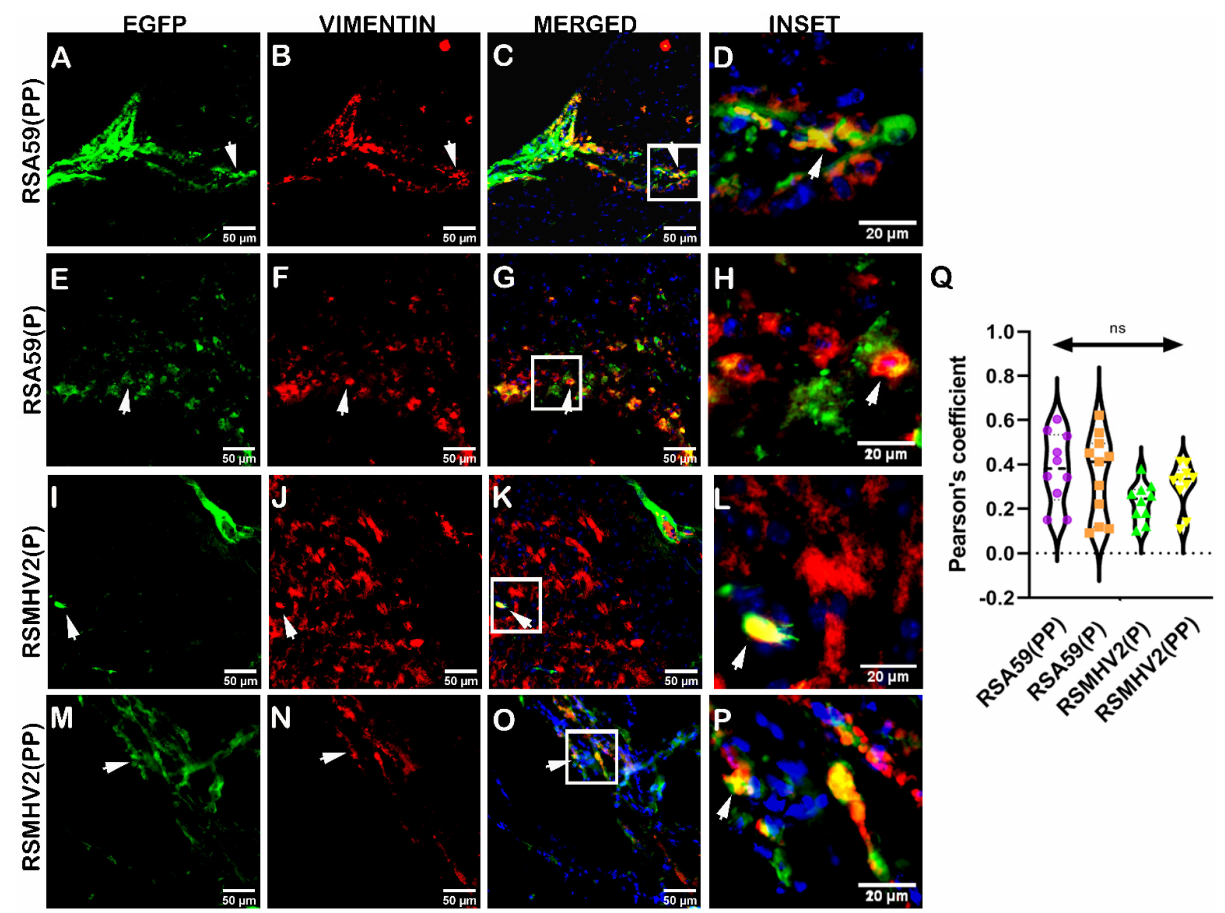
Figure 11. Colocalization of two proline containing strains RSA59(PP), RSMHV2(PP) and single proline containing strains RSMHV2(P) and RSA59(P) infection with choroid plexus fibroblasts in the brain of mice at day 5 p.i. Cryosections of infected mouse brains were immunofluorescently labeled with vimentin ( B , F , J , N ). EGFP images denote infected cells in the tissue ( A , E , I , M ). Images in panels ( C , G , K , O ) show the merged EGFP and vimentin, with insets marked by a white rectangle area and arrowheads highlighting virus infected fibroblasts. RSA59(PP) infected sections are shown in panels ( A – D ), RSA59(P) infected sections are shown in panels ( E – H ), RSMHV2(P) infected sections are shown in panels ( I – L ), and RSMHV2(PP) infected sections are shown in panels ( M – P ). A magnified view of the insets in the merged panels showed the colocalization of EGFP with vimentin-positive cells (seen as yellow) in panels ( D , H , L , P ). The degree of colocalization as the Pearson coefficient was plotted in the violin diagram ( Q ). The One-way ANOVA was used to compare RSA59(PP) with RSA59(P), RSMHV2(P), RSMHV2(PP) and RSMHV2(P) with RSMHV2(PP). The level of significance was taken at p < 0.05. ns denotes